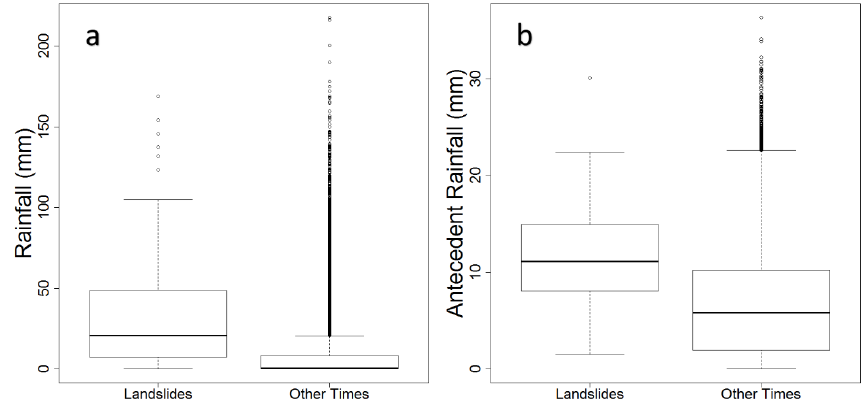
Figure 4. Comparison of (a) daily rainfall and (b) antecedent rainfall distributions (in mm) for days with and without reported landslides. Results are plotted only for locations where landslides were historically recorded and include 123 landslides from Central America and 316697 data points from times landslides were not reported. Due to the limitations of the GLC, it is likely that unreported landslides have occurred in the category we are classifying as “other times”. The distributions substantially overlap, suggesting that daily and antecedent rainfall thresholds cannot classify the data perfectly into landslide events and non-events.